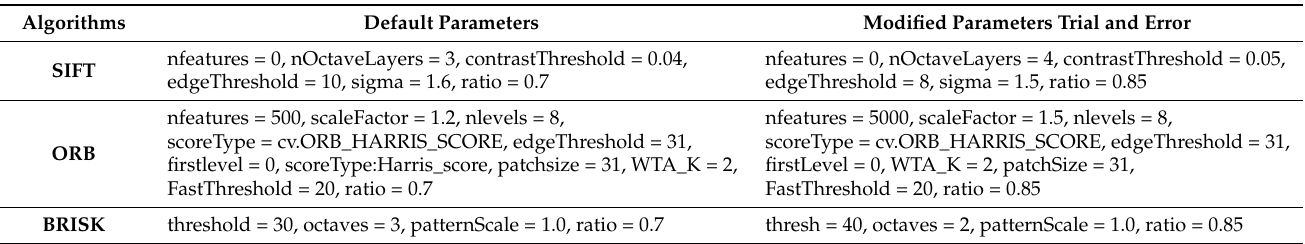
Table 2. Default and modified parameters of